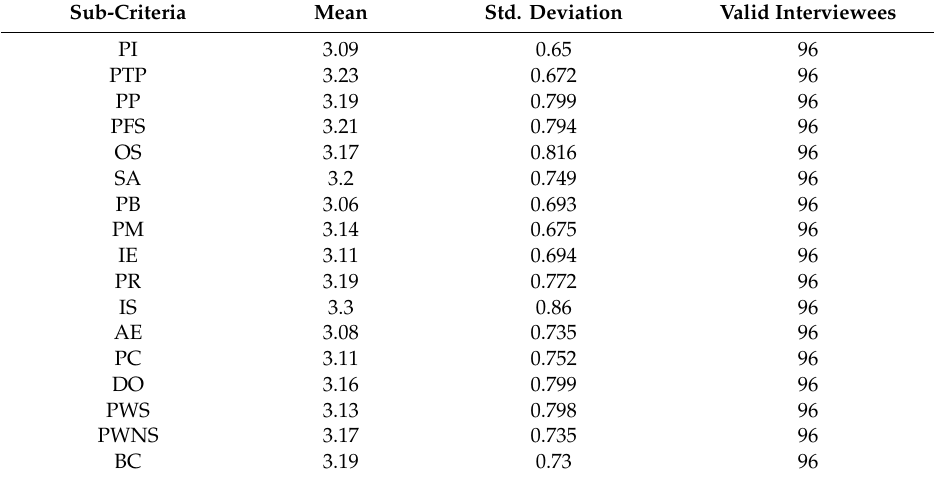
Table 2. Mean and standard deviation Statistics of the 96 random surveyed e-commerce customers.